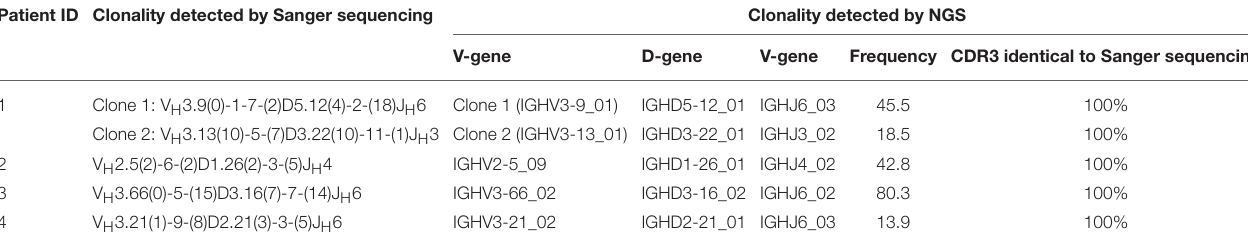
TABLE 2 | Results of clonality detection. Patient ID Clonality detected by Sanger sequencing Clonality detected by